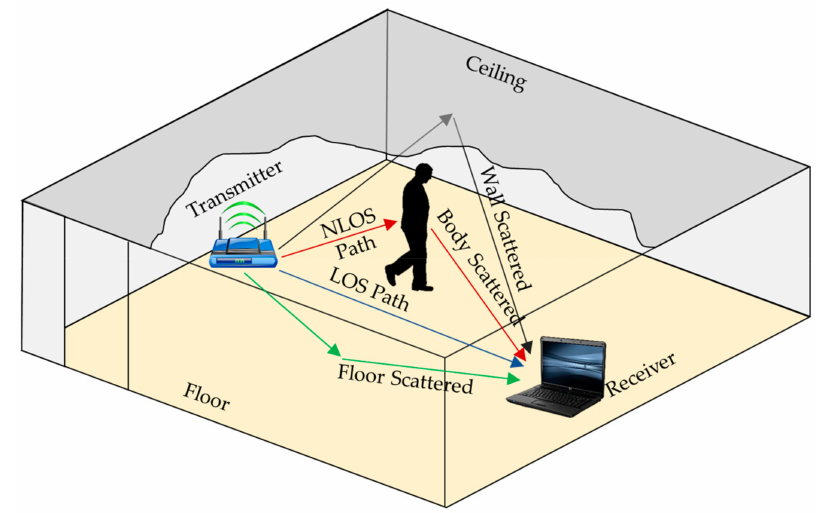
Figure 2. Wi-Fi signal propagation in an indoor